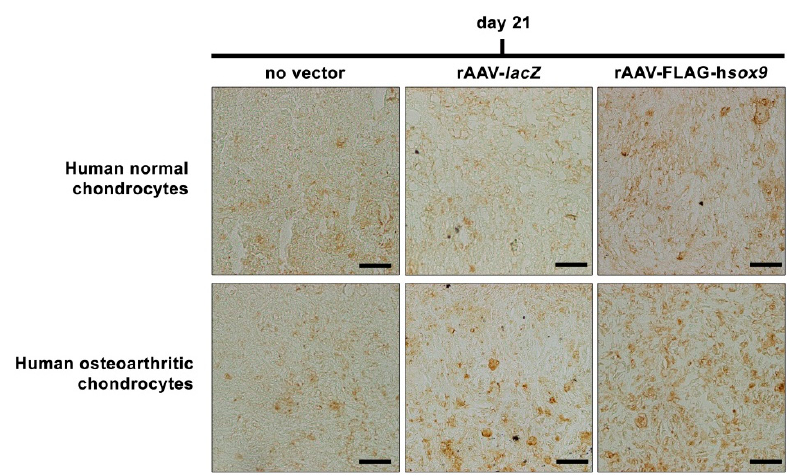
Figure 3. Transgene (SOX9) expression in rAAV-transduced aggregate cultures of human normal and OA chondrocytes. Cell aggregates were transduced with rAAV-FLAG-h sox9 versus rAAV- lacZ (40 μ L each vector) or lack of vector treatment as described in Figures 1 and 2 and in the Materials and Methods. SOX9 expression was monitored after 21 days by immunohistochemistry as described in the Materials and Methods (magnification x40; all representative data of the central region of the aggregates). Scale bars: 20 μ m. Table 1. Histomorphometric analyses in rAAV-transduced aggregate cultures of human normal and OA chondrocytes (day 21). Assay